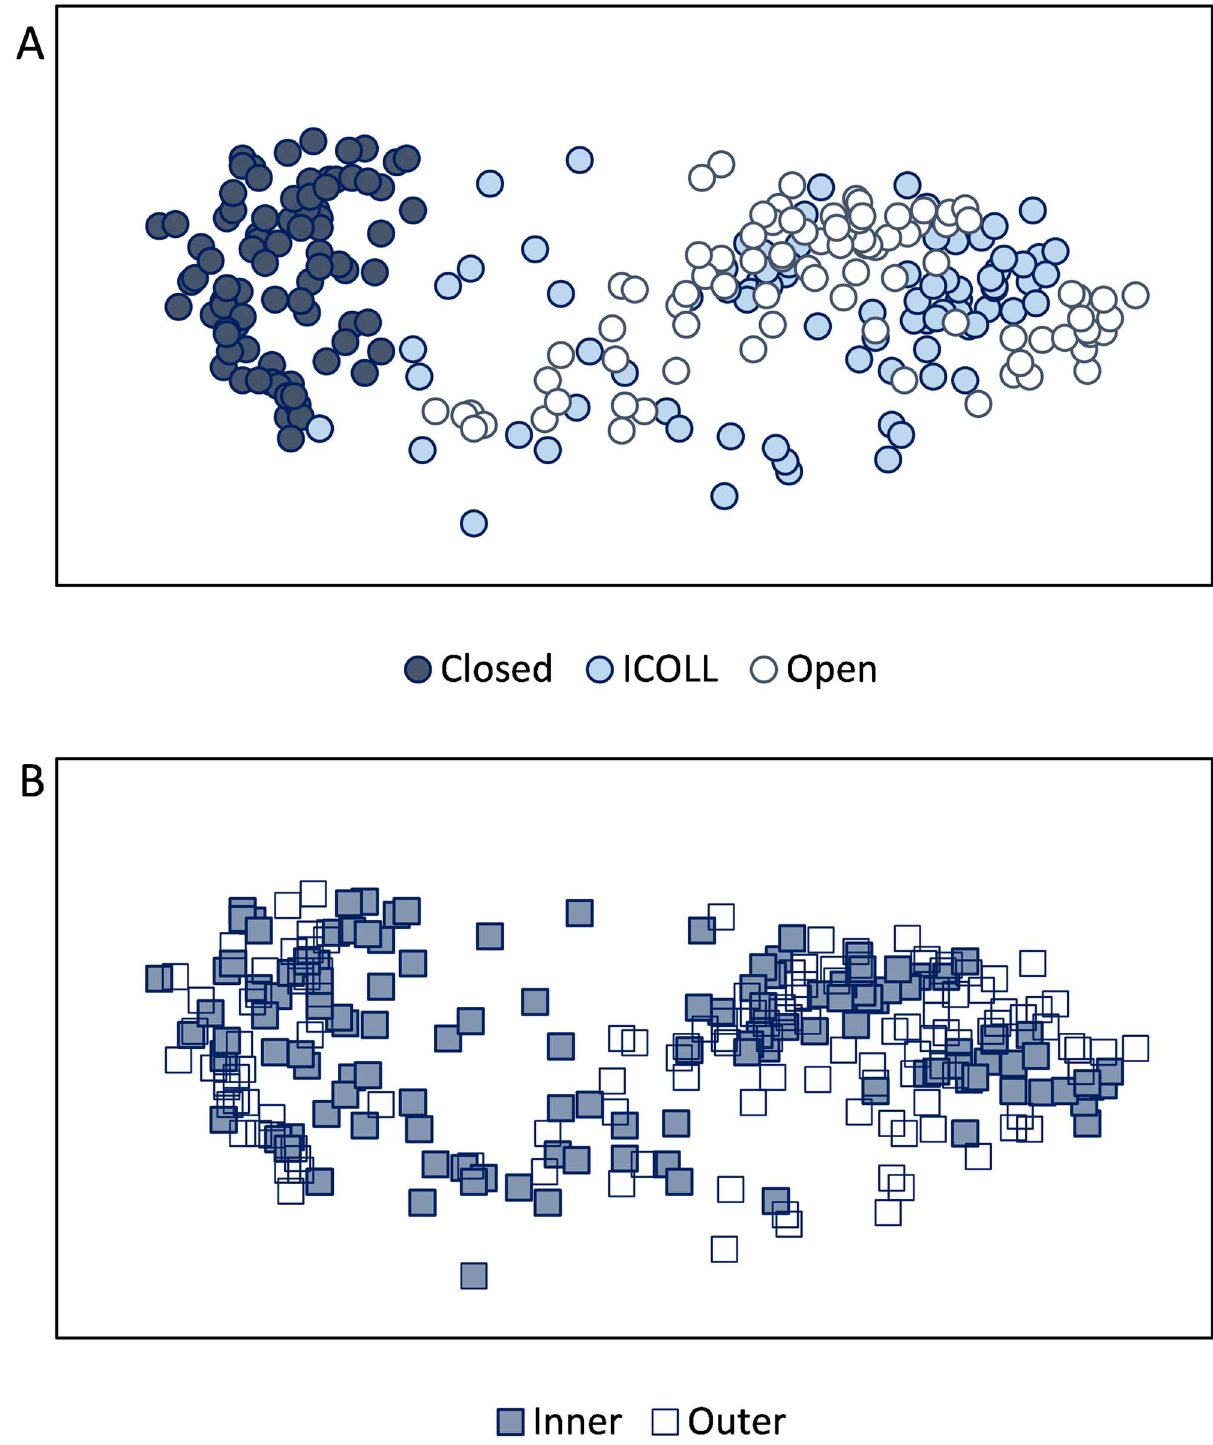
Fig 5. nMDS ordinations for log-transformed nematode abundances. (A) closed, intermittentlyopen/closed (ICOLL) and open lagoons. (B) inner and outer portions of coastal lagoons. Stress 0.16.